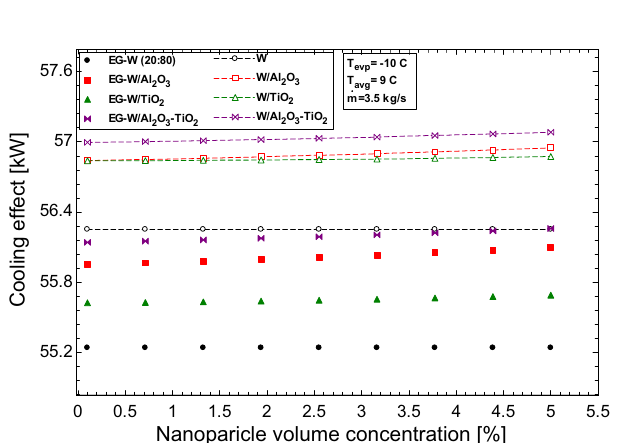
Figure 4. Effect of ( A ) evaporator temperature and ( B ) secondary fluid inlet temperature on the overall heat transfer coefficient in the evaporator.